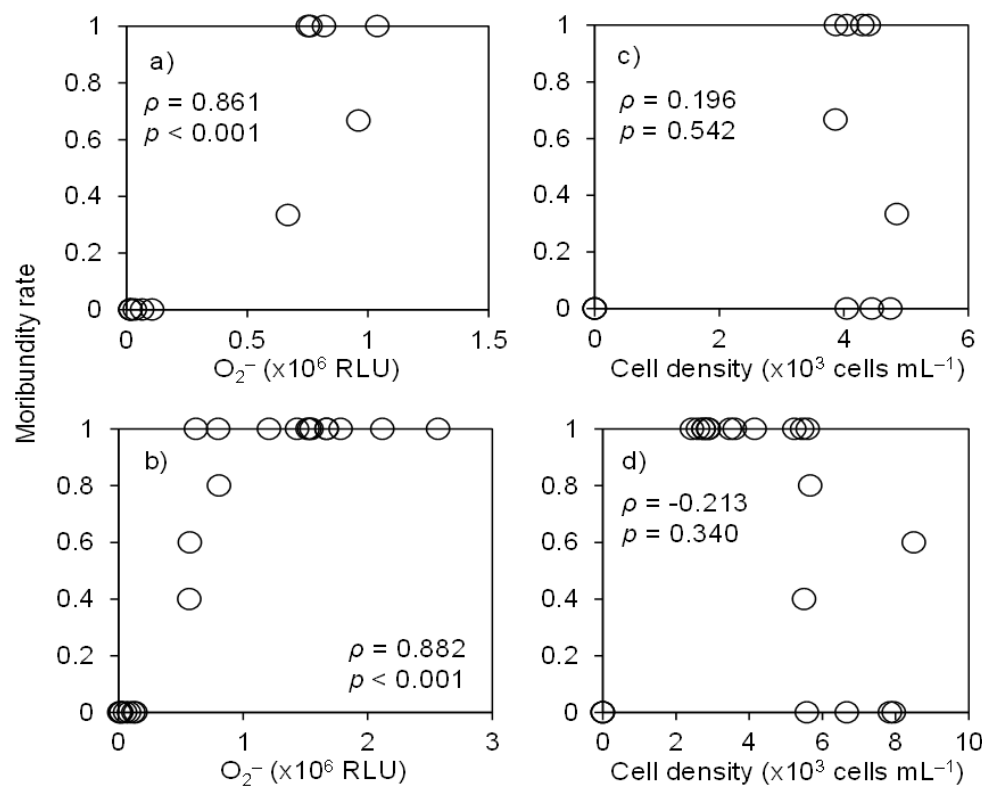
Figure 7. Relationship between superoxide level ( a , b ) and cell density ( c , d ) of Chattonella cultures, and toxicity to red sea bream ( a , c ) and yellowtail ( b , d ) in the bioassays shown in Figure 2 (high DO conditions) and Figure 3. RLU, relative luminescence units. Data of control (no Chattonella cell) are also included.